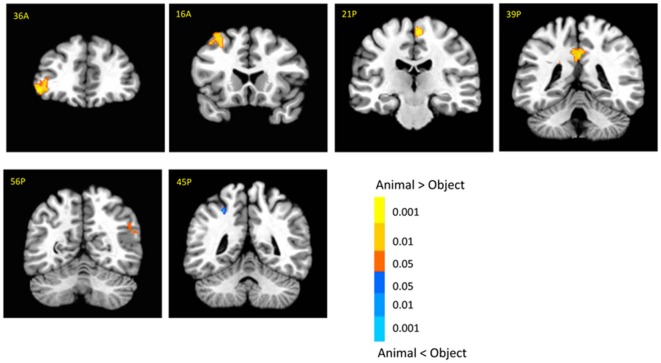
Cortical activation for category effect. Animal pictures elicited stronger activation than objects in the left anterior prefrontal cortex (PFC), left superior PFC, mPFC, anterior cingulate cortex (ACC), angular gyrus and temporal gyrus, and objects elicited stronger activation than animals in the left intraparietal lobe (IPL). The color bar represents the contrast of animal vs. object (with warm color as animal > object), and represents p-values for t-statistics. The left is on the left side. The number/alphabet combinations at the top left corner of each brain image refer to the y-coordinates in the standard Talaraich atlas.